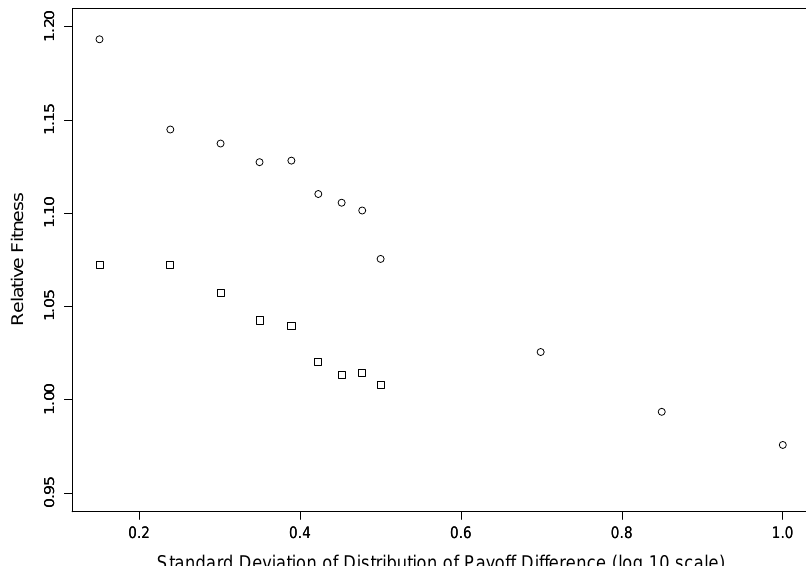
Figure 2. The effect of rates of change in the environment on relative fitness gain associated with payoff biases. The squares represent cases where rate of change is low ( γ = 0.01, squares) and the circles the cases where it is high ( γ = 0.1), circles The x-axis represents the quality of the payoff √ v on a log10 scale. Other parameters are as follow: n = 3, ξ = information, i.e.,